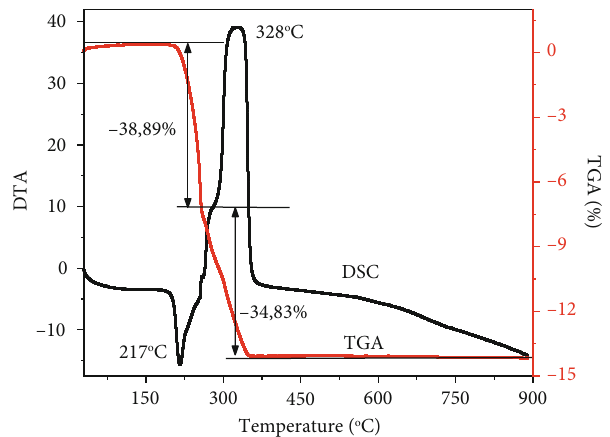
Figure 1: TGA and DTA spectra of the gel sample with the CF/TA ratio of 1:3.